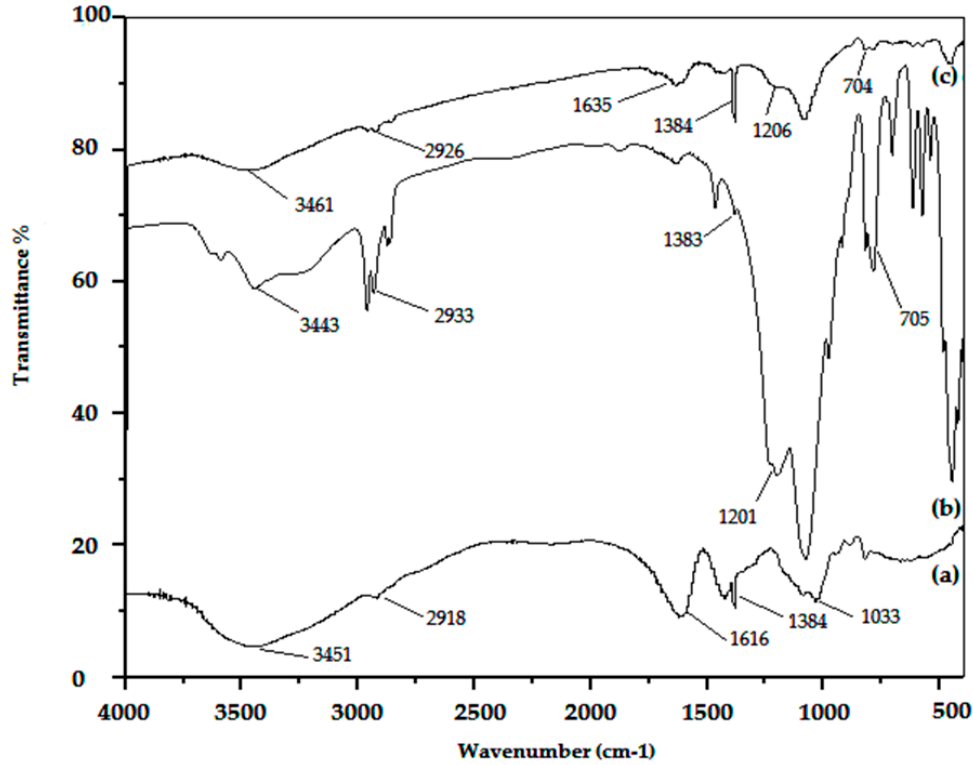
Figure 1. FTIR analyses of the sorbent material. ( a ) CA; ( b ) HM-D2EHPA; ( c ) CAM-D2EHPA.